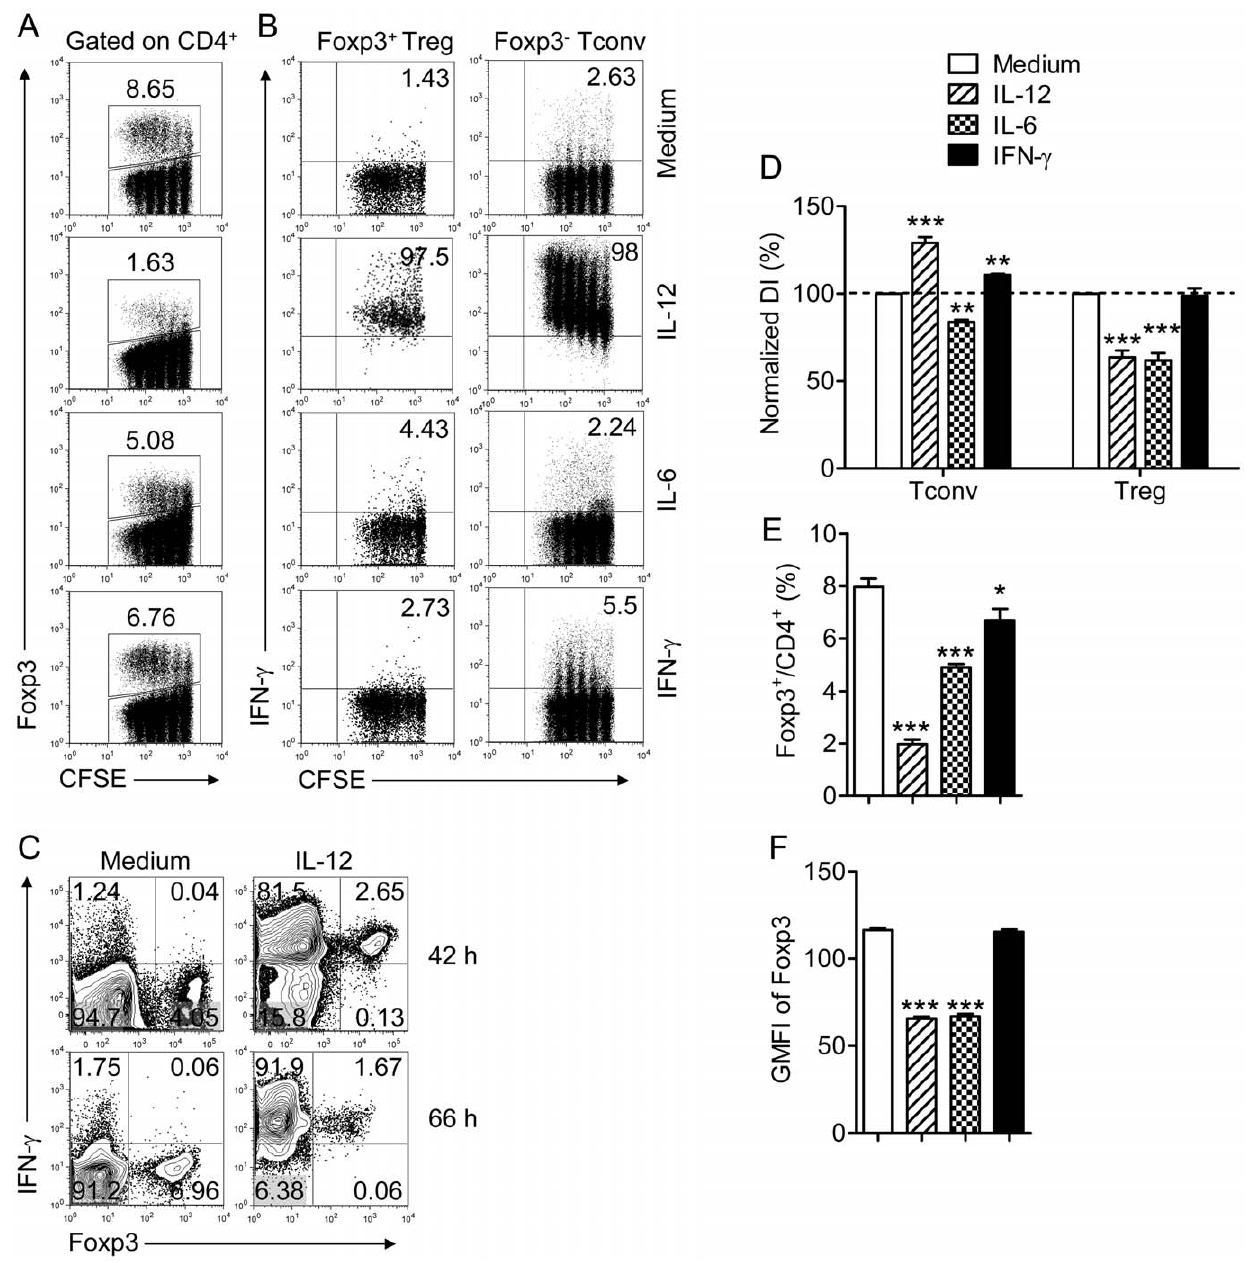
Figure 1. IL-12, but not IL-6 or IFN- c induces IFN- c expression by Foxp3 + Tregs. Lymphocytes were prepared from lymph nodes of naı¨ve B6 mice, labeled with CFSE and stimulated with anti-CD3 mAb and the indicated cytokine for 66 hr. Cells were then stimulated with PMA and ionomycin for 4 hr. (A) Percentage and CFSE dilution of Foxp3 + Tregs in the CD4 T cell population. (B) IFN- c expression by Tconvs (Foxp3 2 ) or Tregs (Foxp + ) after exposure to IL-12 (1 ng/ml), IL-6 (25 ng/ml) or IFN- c (100 ng/ml). (C) IFN- c expression by Tconvs (Foxp3 2 ) and Tregs (Foxp + ) after exposure to IL-12 for 42 or 66 hr. (D) Division indices (DI) were calculated for Tconvs and Tregs and normalized to the groups treated with medium. Data are from three independent experiments. (E) Percentage of CD4 T cells expressing Foxp3 after treatment. Data were acquired from 4–9 independent experiments. (F) Geometric mean fluorescent intensity (GMFI) of Foxp3 in Tregs after indicated treatment, measured in triplicate. Data are from one experiment representative of 3 independent experiments. * P , 0.05, ** P , 0.01, *** P , 0.001 compared to cells exposed to medium, Student’s two-tailed paired t tests (D) or un-paired t tests (E, F).